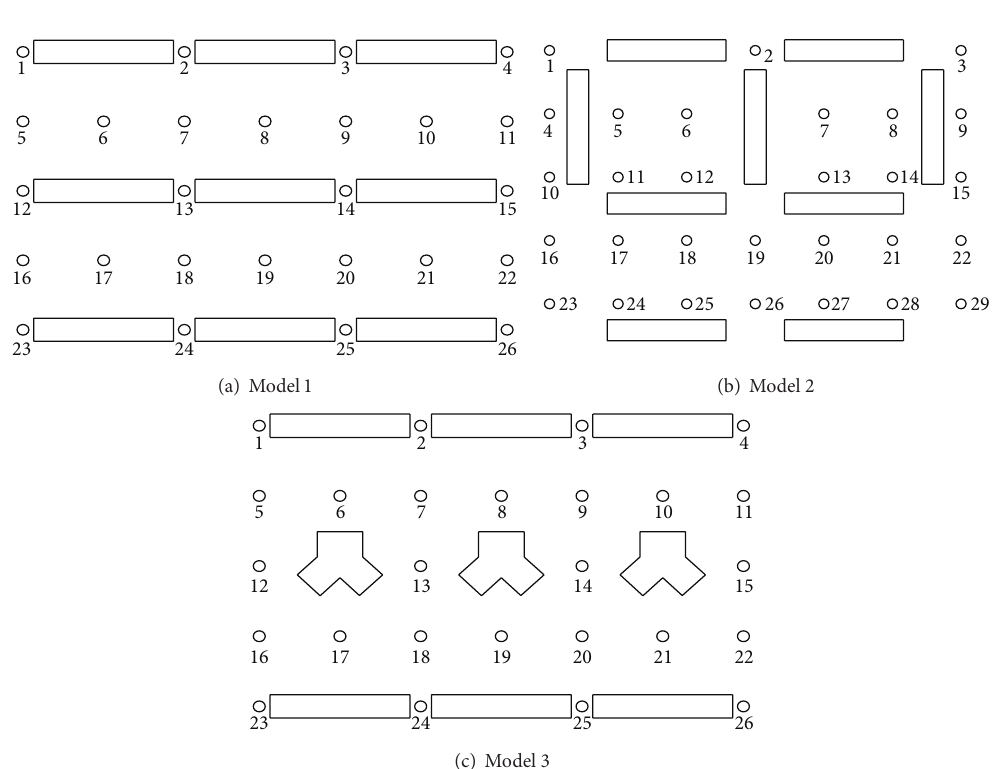
Figure 2: Experimental models.